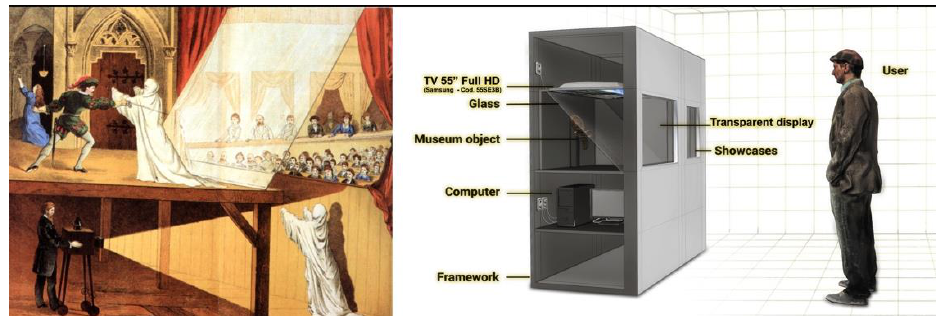
Figure 6. The Pepper’s Ghost technique used in theaters in the nineteenth century (left), and scheme of the current set up using digital technologies (right).